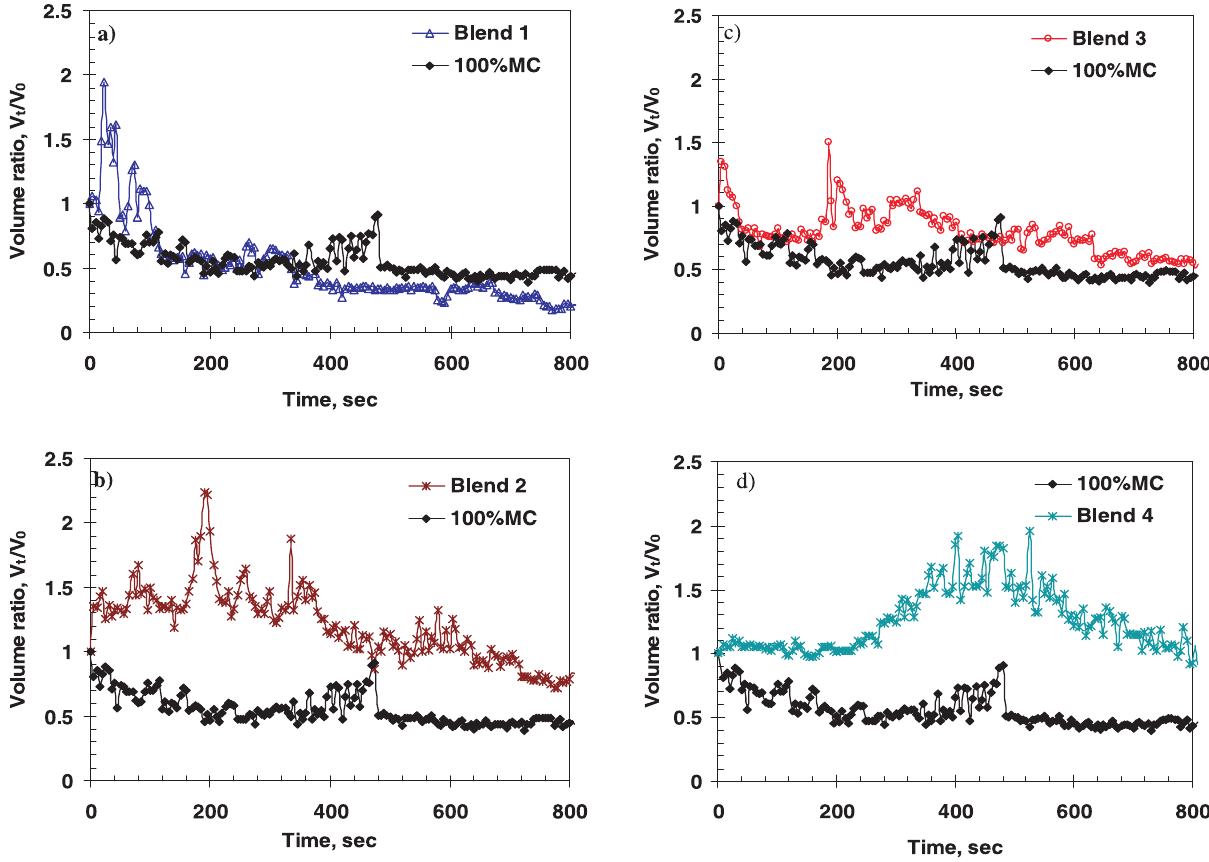
Fig. 5: Carbon/slag interactions for metallurgical coke/slag and a) Blend 1/slag, b) Blend 2/slag, c) Blend 3/slag and d) Blend 4/slag system at 1550 °C: volume ratio (V /Vo) as a function of t